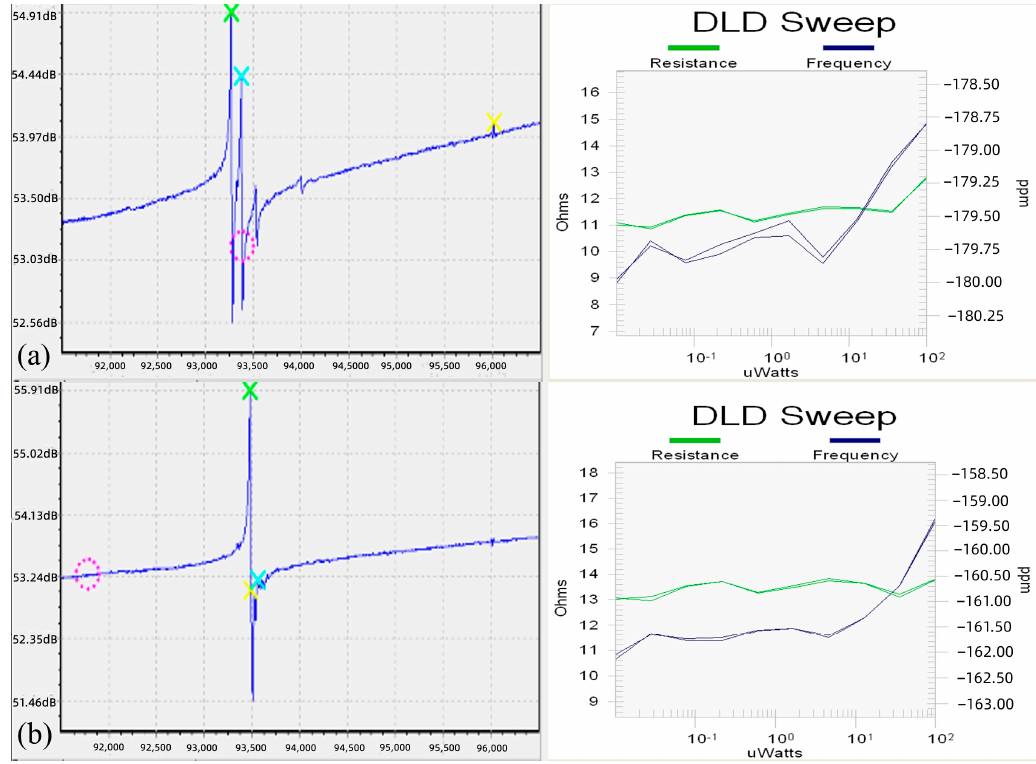
Figure 7. Frequency waveform and DLD scan curve after etching: ( a ) the 6th group; ( b ) the 7th group.